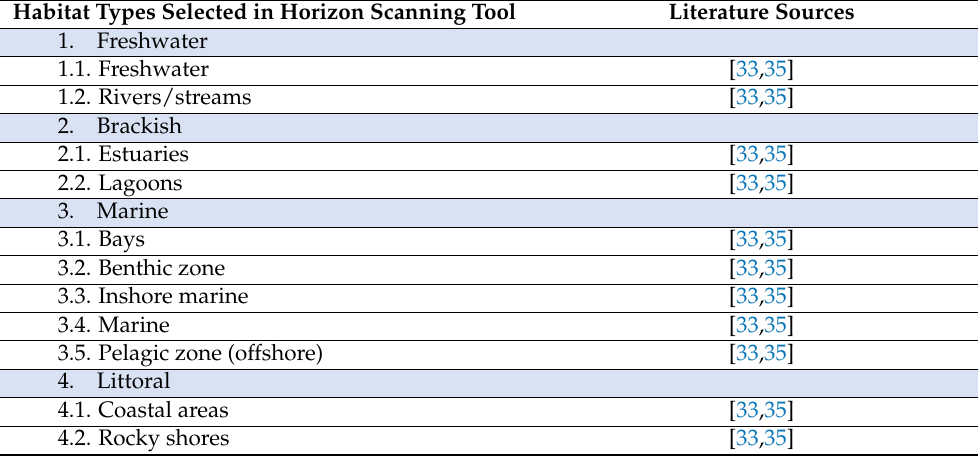
Table 2. Possible habitats of potential IAS to the Baltic